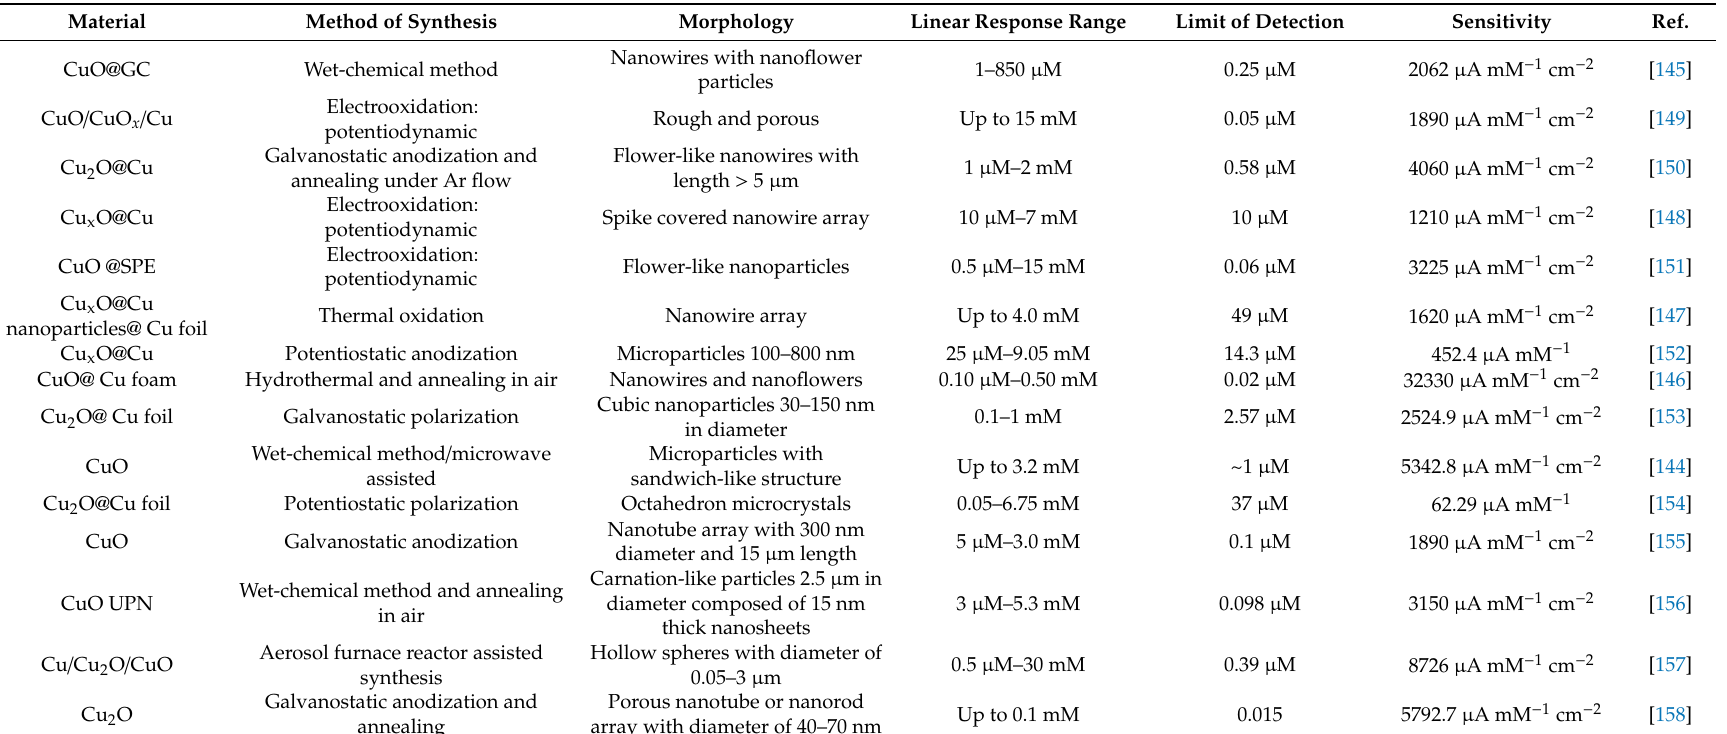
Table 3. Overview of selected reports on non-enzymatic Cu-derived glucose sensors